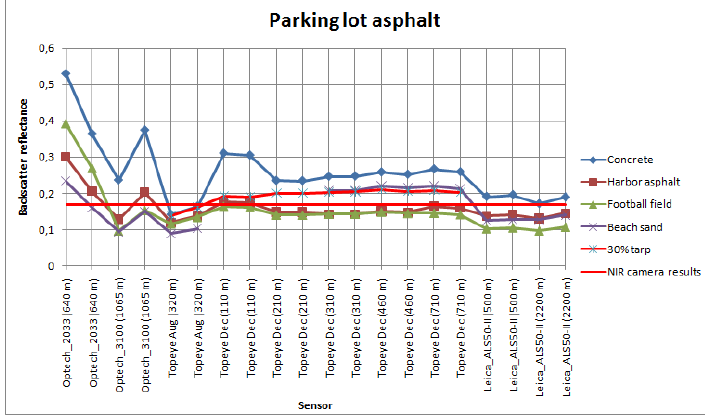
Figure. 7D. Backscatter reflectances of the parking lot asphalt sample calibrated with different samples as reference.